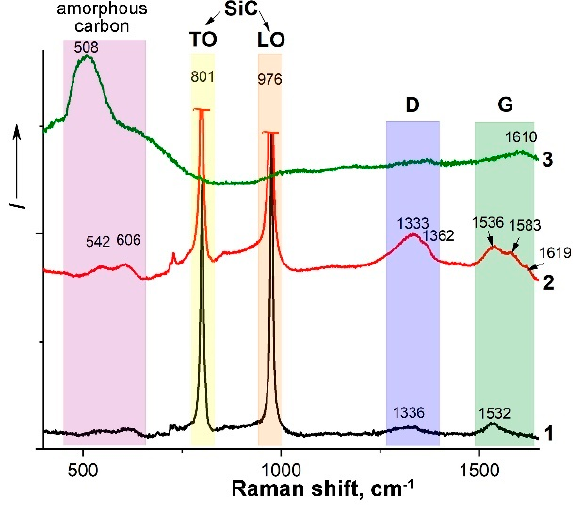
Figure 3. Raman spectra of the surface of ceramic samples ZHS (1), ZHSC (2), as well as the surface of the ZHSC sample after exposure to a supersonic flow of dissociated nitrogen (3).